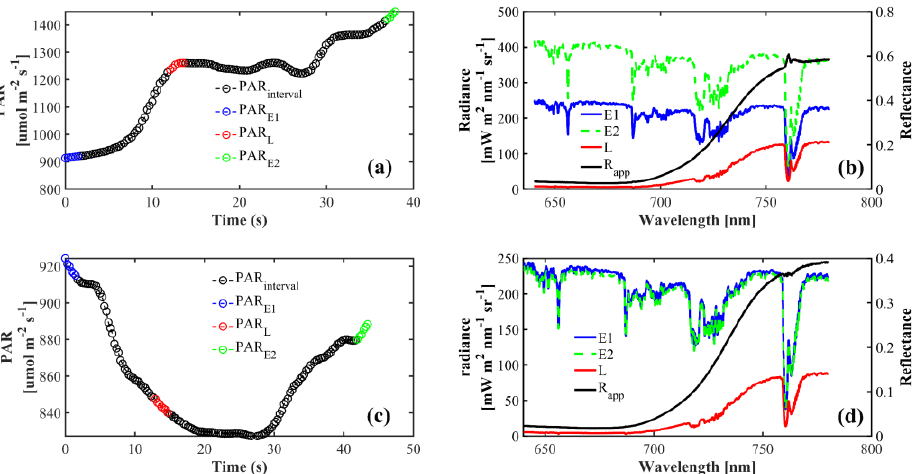
Figure 9. The PAR and spectral data during two measurement cases. ( a , b ) for the case 1 and ( c , d ) for the case 2. The red dots, blue dots, and green dots represent the PAR measured during the upwelling radiance measurement (L) and two irradiance measurements (E1 and E2) acquired just before and immediately after the L measurement, respectively. The blue solid line, green dotted line, and red solid line represent the spectra of E1, E2, and L, respectively. The black solid line represents the reflectance ( 𝑅 𝑎𝑝𝑝 ) of the maize canopy calculated by E1 and L.